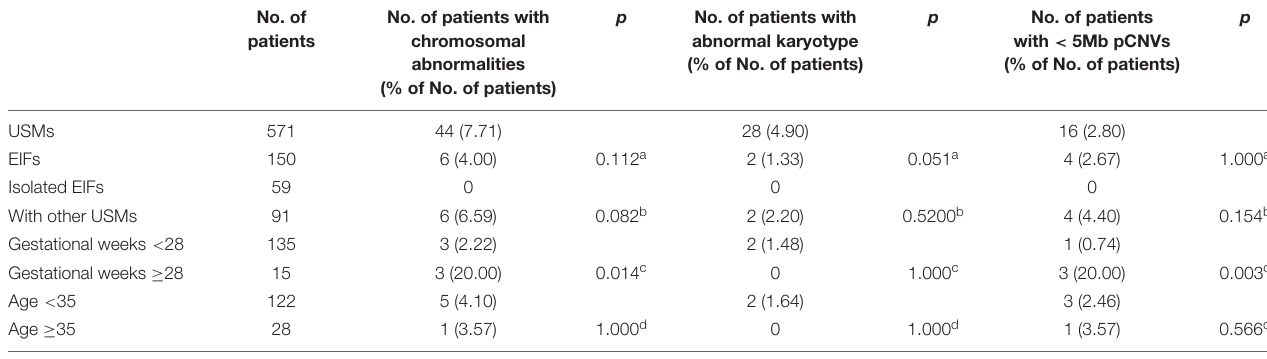
TABLE 2 | Incidence of chromosomal abnormalities in fetuses with EIFs and USMs.